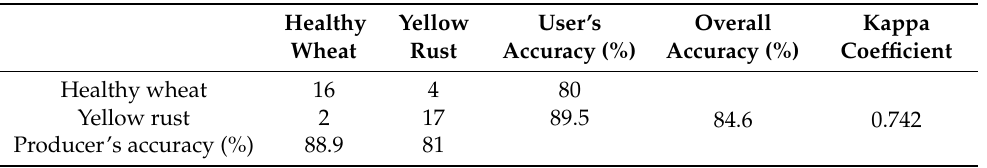
Table 10. Confusion matrix and kappa value for the monitoring results based on KPCA-SVM of the yellow rust in Ningqiang county